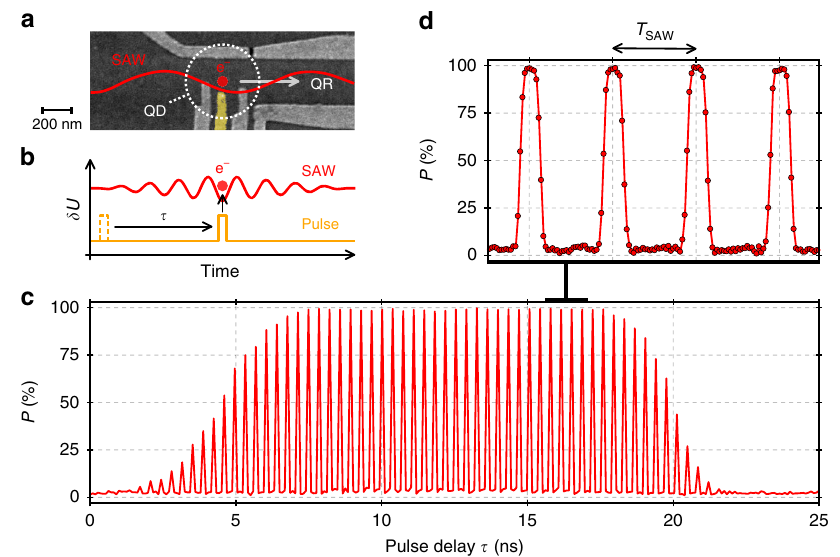
Fig. 4 Pulse-triggered single-electron transfer. a SEM image of the source quantum dot (QD) showing the pulsing gate highlighted in yellow. A fast voltage pulse on this gate allows one to trigger SAW-driven single-electron transport along the quantum rail (QR) as schematically indicated. b Measurement scheme showing the modulation, δ U , of the electric potential at the stationary source QD: the delay of a fast voltage pulse, τ , is swept along the arrival window of the SAW. c Measurement of the probability, P , to transfer a single electron with the SAW from the source to the receiver QD for different values of τ . d Zoom in on a time frame of four SAW periods, T